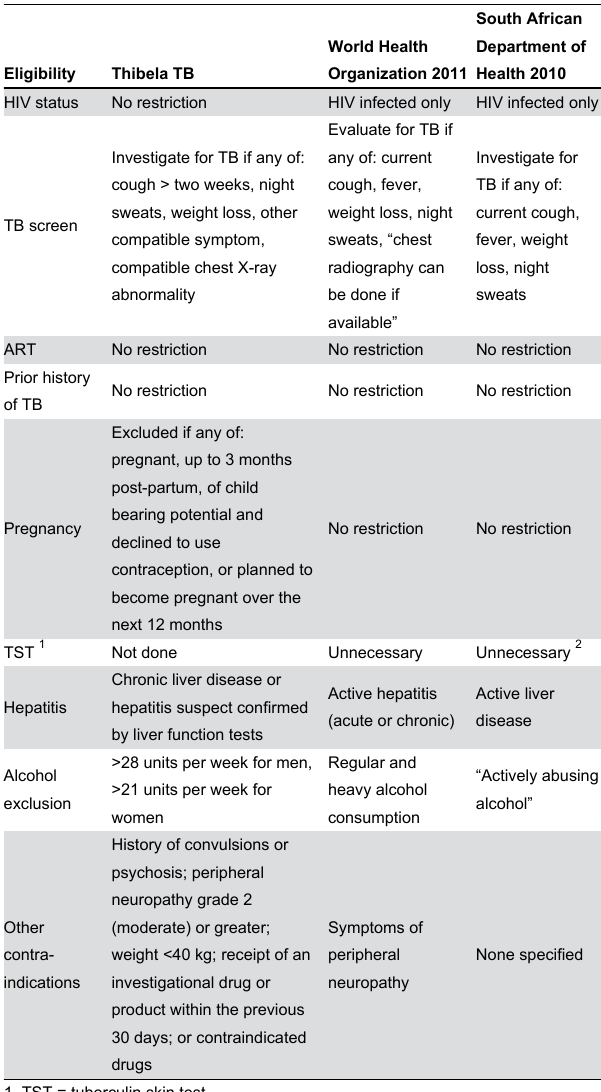
Table 1. Eligibility criteria for isoniazid preventive therapy, contrasting those for the Thibela TB study to those of the guidelines from the World Health Organization in 2011 [2] and the South African Department of Health in 2010